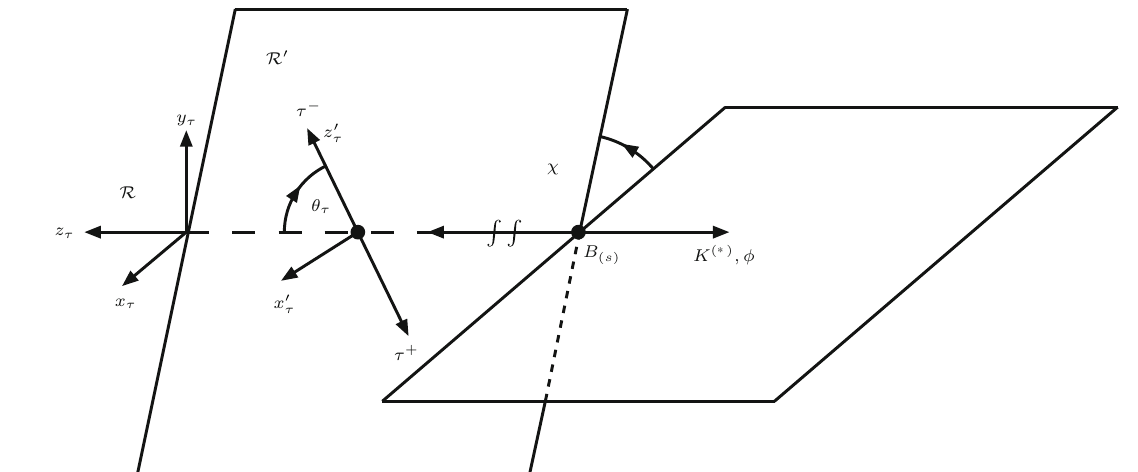
Fig. 3 Relevant reference frames. The four-momentum of the B ( s ) constituting a right-handed frame). The longitudinal polarization of the τ − lepton is defined along the z (cid:8) meson is k , while the one of the final-state meson is p . The four- τ axis, while the transverse (or normal) momenta of the τ − and τ + are p − and p + , respectively, and q 2 = polarization is parallel (respectively, orthogonal) to the plan x (cid:8) τ Oz (cid:8) τ . A ( p − + p + ) 2 is the dilepton invariant mass. The R ττ , R (cid:8) similar construction applies to the τ + lepton. The angle θ τ describes (cid:13) (cid:13) ττ reference frames correspond to a boost (indicated by “ ”) from the B ( s ) meson the orientation of the negatively charged lepton. For M = K ∗ ,φ , their rest-frame towards the reference frame of the τ + τ − pair, and the refer- subsequent decay products define a plane, also indicated, with relative orientation given by ence frame R ττ is determined from the rotation of R (cid:8) ττ (with (cid:14) x (cid:8) τ , (cid:14) y (cid:8) τ , (cid:14) z (cid:8) τ